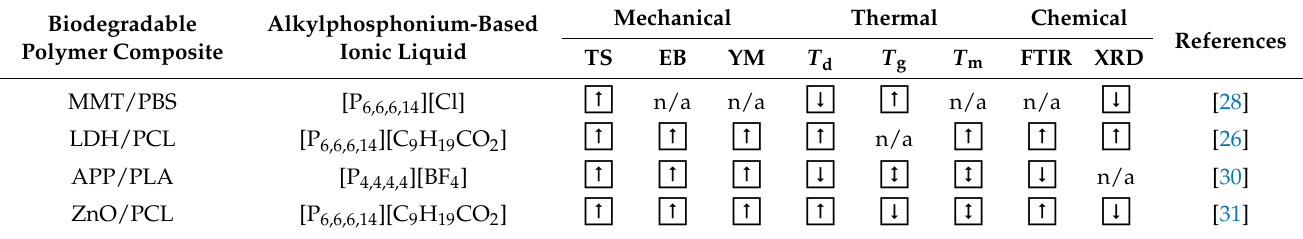
Table 6. Mechanical, thermal, and chemical properties of biodegradable polymer composites influenced by alkylimidaz- olium-based ionic liquids. TS = tensile strength, EB = elongation at break, YM = Young’s modulus, T d = decomposition temperature, T g = glass transi- tion temperature, T m = melting temperature, FTIR = Fourier transform infrared, and XRD = X-ray diffraction. The symbol ‘ ⬆ ’ corresponds to an increase in the properties, and ‘ ⬇ ’ corresponds to a decrease in the properties, while ‘ ↕ ’ and ‘n/a’ describe unchanged and not available, respectively.